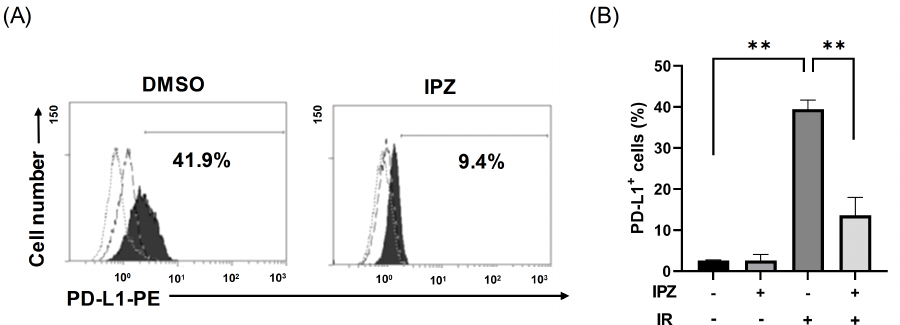
Figure 1. Effects of IPZ on radiation-increased PD-L1 expression on the surface of A549 cells. ( A , B ) IPZ (10 µ M) was added to the culture medium at 1 h before X-ray irradiation at 6 Gy. After 4 days of culture, the cells were harvested for the analysis of cell-surface PD-L1 expression. ( A ) Rep- resentative histograms of PD-L1 expression on A549 cells are shown. The dotted and broken line histograms indicate isotype control and PD-L1 expression of non-irradiated cells, respectively. The filled black histogram indicates the PD-L1 expression of irradiated cells. Inset numbers indicate the percentage of PD-L1 + cells of 6 Gy-irradiated cells compared with an isotype control. ( B ) Data are presented as the mean ± SD of independent experiments. ** p <